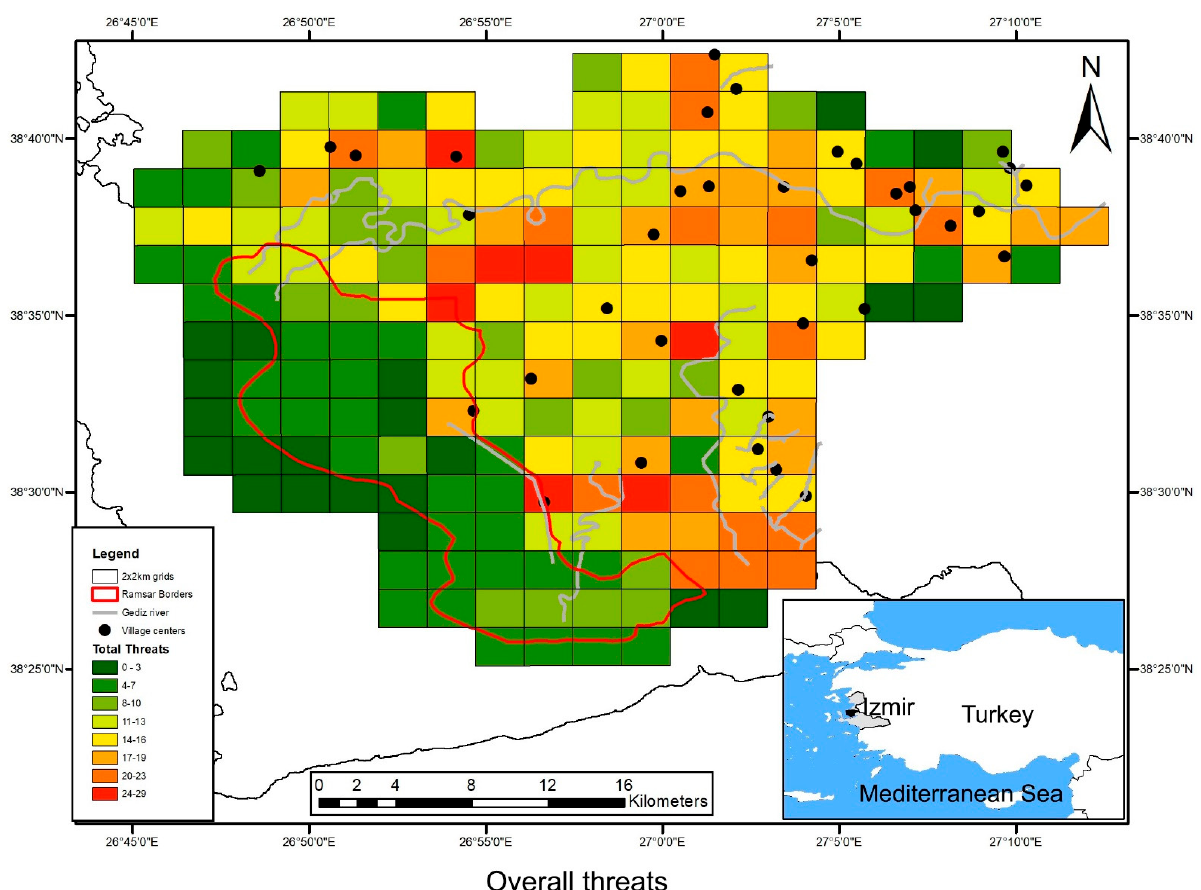
Figure 4. Global threat heat map of the Gediz Delta with green representing the lowest threat rankings and red representing highest threat rankings.